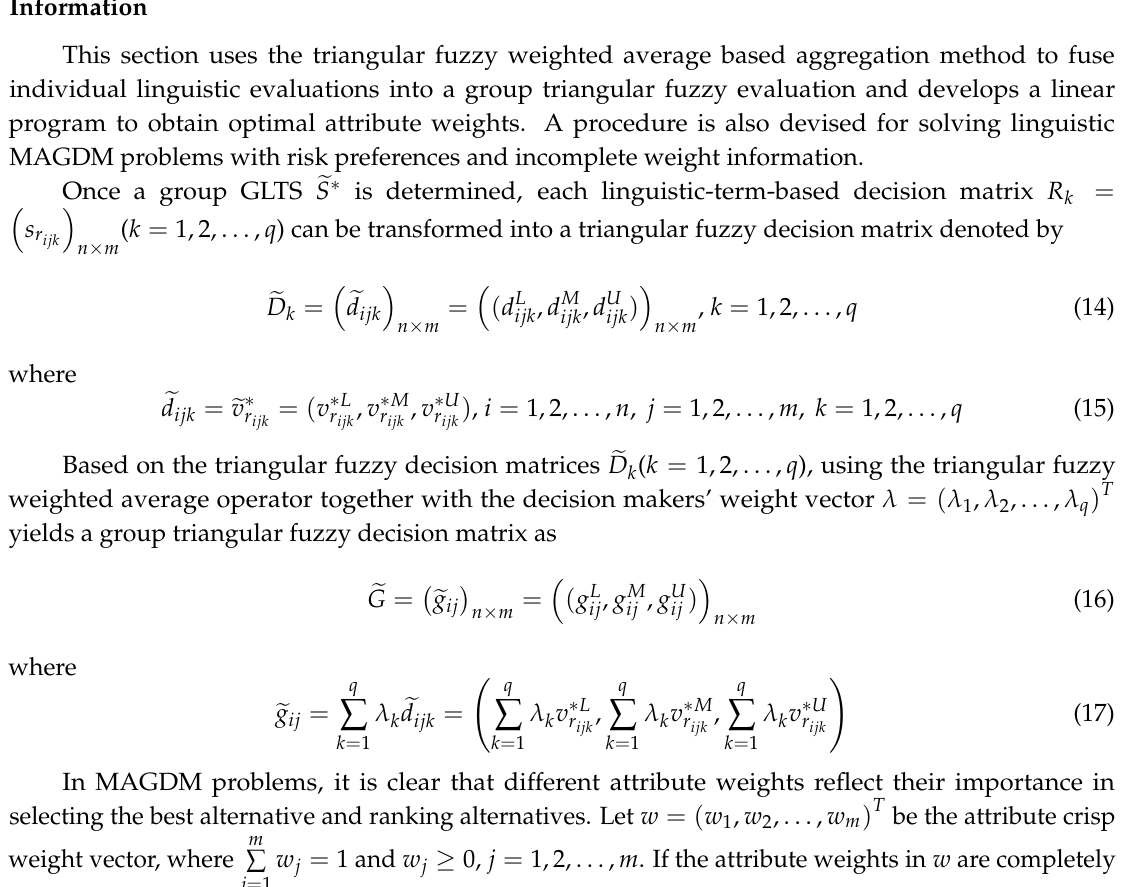
Figure 1. Distribution of the semantic values of the generalized linguistic term sets (GLTS)